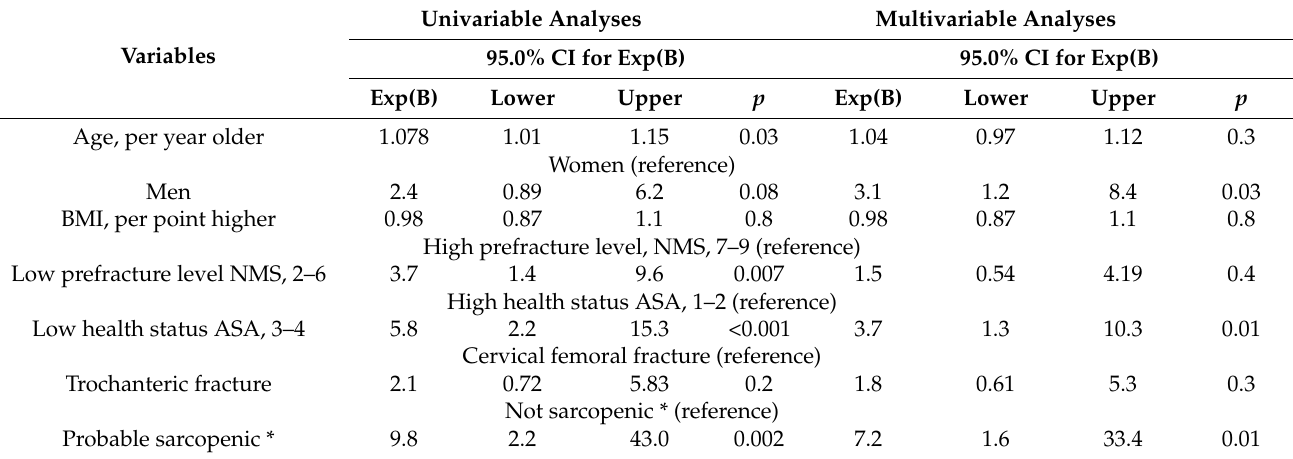
Table 2. Crude and adjusted hazard ratios of 1-year mortality according to presence of a sex-specific probable sarcopenic status, n =